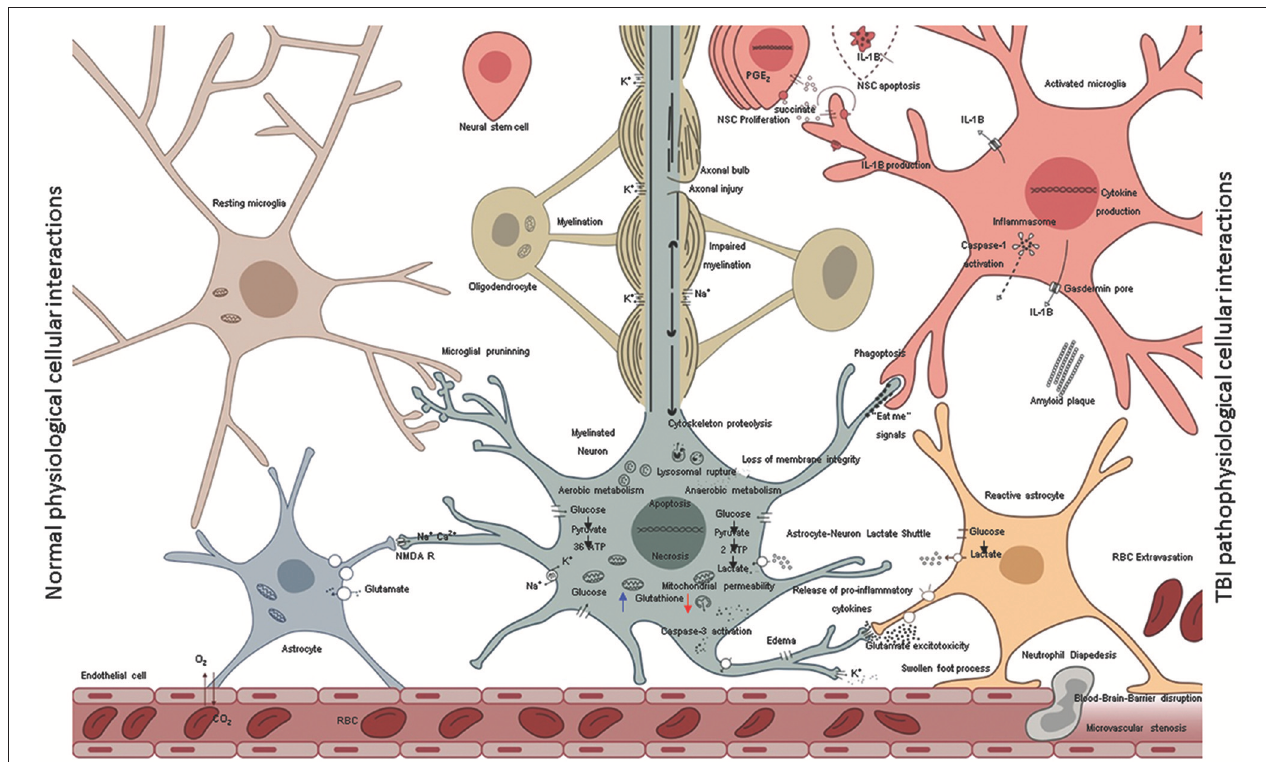
FIGURE 3 | A schematic representation shows the normal cellular interactions in the intact brain (left) in contrast to neurotoxic interactions post injury (right). The intact vasculature (left bottom) is held in place by astrocytic end-feet; astrocytic blood brain barrier keeps immune cells out of the parenchyma but allows diffusion of glucose. Glucose is taken by neural cells metabolized through glycolysis in cytoplasm and oxidative phosphorylation in mitochondria. High neuronal glutathione levels (blue arrow) mitigate oxidative damage due to inherent metabolic activity. The multipartite synapses are pruned by microglia, the axons wrapped by myelin from oligodendrocytes facilitate rapid neurotransmission. Astrocytes soaking up excess glutamate in synapses, which in turns increases glucose uptake from blood. Normal microglia phagocytose various extracellular debris (including amyloid β ) produce by metabolic activity. Aberrant cellular interactions after TBI (right) as consequence of mechanical forces disrupt the blood-brain-barrier causing leakage of intravascular contents into the brain parenchyma and facilitate invasion of the CNS with non-resident cells such as RBCs and neutrophils. Initial trauma causes the release of glutamate and other excitatory amino acids and potassium efflux. Lowered neuronal glutathione levels lead to deceased capacity to inhibit excitatory neurotransmission. Ions with their water shells enter astrocytes swelling the cells such that end-feet of astrocytes fail to maintain blood barrier or clear synaptic glutamate. Excess glutamate binds NMDA receptors on neurons and oligodendrocytes. Resulting neuronal depolarization and accumulation of calcium in mitochondria abolishes normal electrochemical gradient required to generate ATP. ATP dependent ion pump activity is required to work against electrochemical gradient to hyperpolarize neurons. Due to irreversible ionic imbalance membrane integrity is lost, unraveling the myelin and death of neurons and oligodendrocytes. This process is called “glutamate excitotoxicity” produces the second wave of TBI related cell death after the primary mechanical injury. Calcium pollution renders mitochondria depolarized, builds up oxidative damage, opening of the permeability transition pore, lipid peroxidation, cytochrome c release, assembly of caspase dependent proteases, and apoptosis. In addition, with injured axons calpain-induced lysosomal rupture, cathepsin-induced cytoskeletal proteolysis set into motion the self-destructive axonal degeneration. Hypoxia stabilizes HIF-1 α facilitating expression of pro-inflammatory cytokine genes (IL-1 β , IL-18, TNF α ). Succinate acts as a signal that positively feeds inflammation. NSC disrupt such feedback and mediate inflammation resolution by rending microglia anti-inflammatory. Pro-inflammatory cytokines are released in the extracellular environment via pores (ex: IL-1 β via gasdermin D) and spread inflammation to adjacent cells including mitochondrial dysfunction and secondary death of oligodendrocytes, neural stem cells and neurons. Presence of proinflammatory microglia corrupts astrocytes turning them into agents of neurotoxicity. Transient “eat-me” signals on the surface of neurons activate glial Phagoptosis leading to further loss of tissue that was otherwise intact at the time of primary injury. Proinflammatory microglia and neurons may undergo pyroptosis or other inflammatory cell death further spreading the